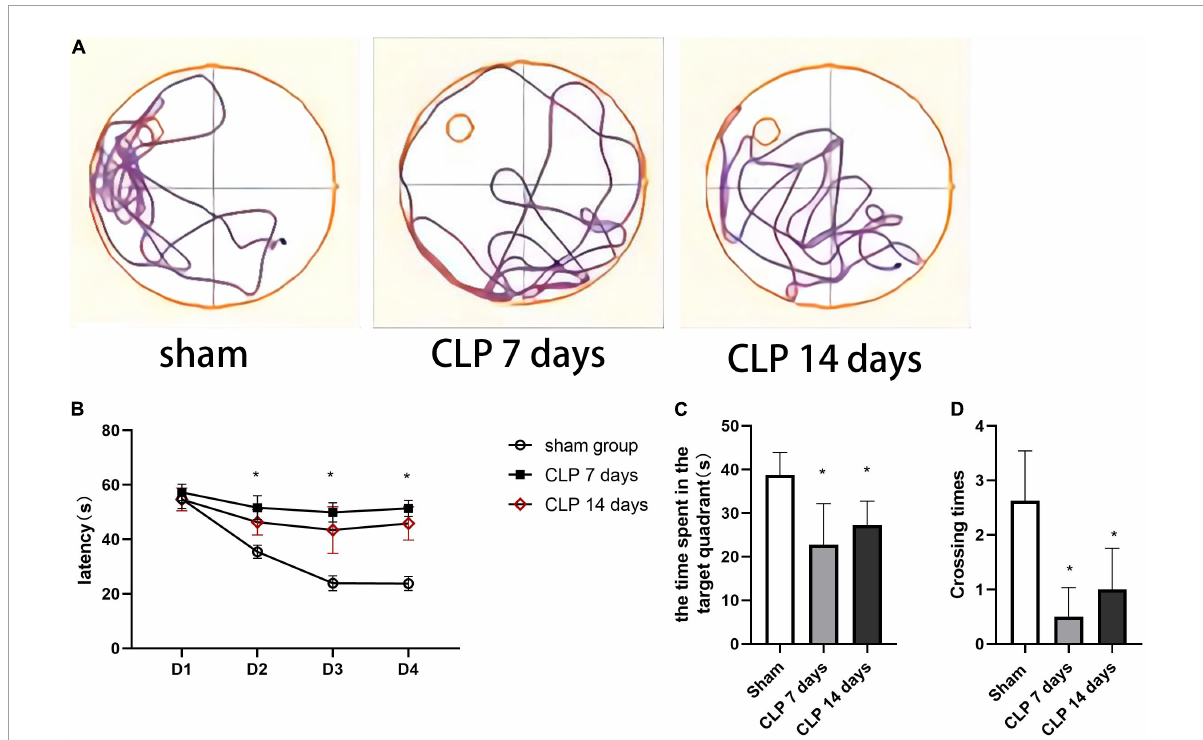
FIGURE5 Cecal ligation and perforation surgery deteriorates cognitive performance in the MWM task. (A) The typical tracks of rats in the three groups in the probe test. (B) The latency of finding the hidden platform in on training days (* p < 0.05, versus sham group, n = 8) analyzed by repeated measures ANOVA and Tukey’s post hoc comparison. (C) The time spent in the target quadrant in the probe trail and (D) the number of crossings the platform location (* p < 0.05, versus sham group, n = 8) analyzed by one-way ANOVA. Data are expressed as the mean ± SD.